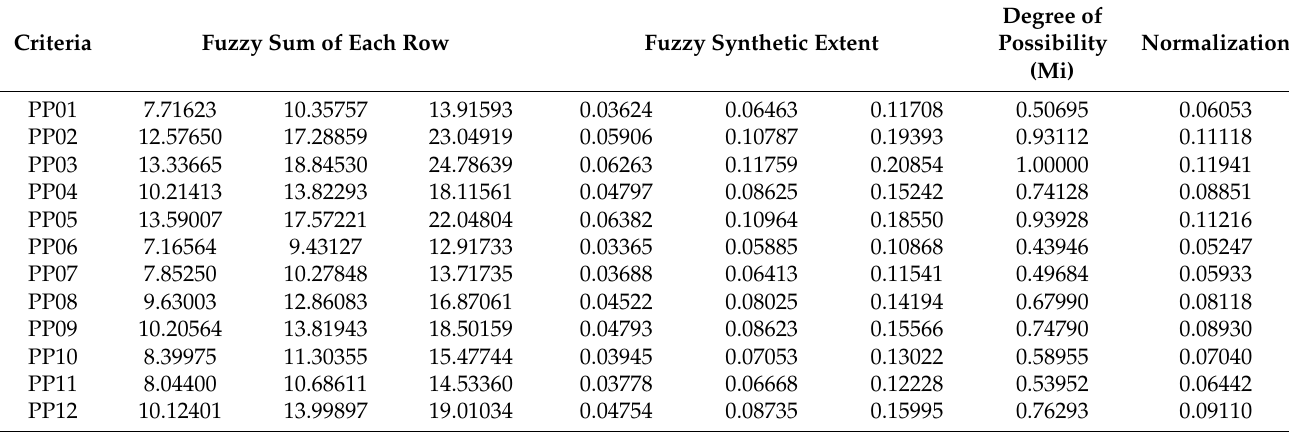
Table 2. The weight of all criteria.